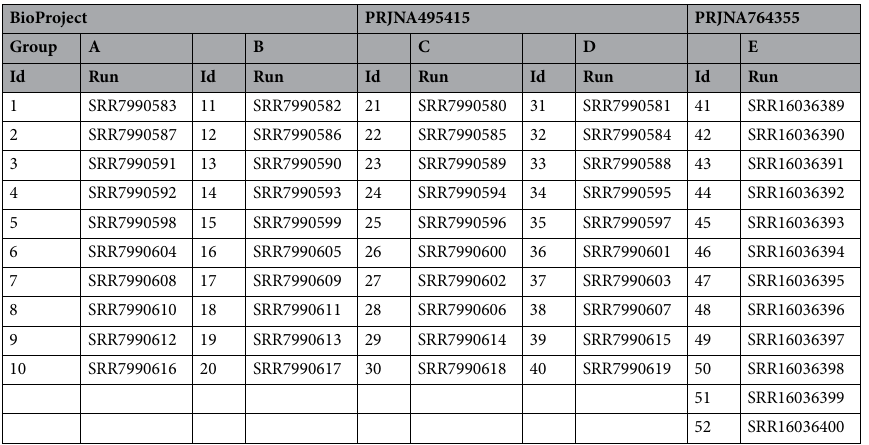
Table 2. Analyzed samples. The samples of dataset PRJNA495415 were taken on days 0, 7, 14 and 28 were classified in groups A, B, C and D, respectively. All samples from BioProject PRJNA764355 are assigned